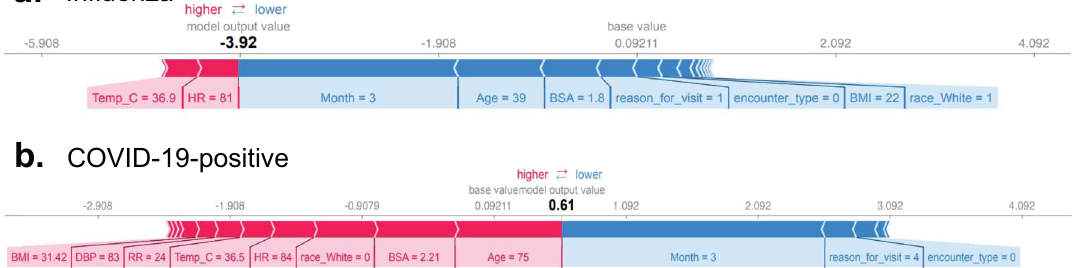
Fig. 4 SHapley Additive exPlanations (SHAP) force plots from an in fl uenza and COVID-19-positive patient. SHAP plots for sample observations from a in fl uenza A/B and b COVID-19-positive predictions. The underlying model is XGBoost. Features that are contributing to a higher and lower SHAP values are shown in red and blue, respectively, along with the size of each feature ’ s contribution to the classi fi cation model ’ s output. The in fl uenza patient in this example shows a log-odds output of − 3.92 in the rating scale, which is equal to a probability of 0.0194. The baseline — the mean of the model output (log-odds) over the training dataset — is 0.092 (translating to a probability of 0.523). The COVID-19-positive patient has a rating score of 0.61 (probability = 0.6479); Age of 75, HR of 84, BSA of 2.21, respiratory rate of 24, and a Temp of 36.5 °C increases the prediction risk, while month of march decreases the predicted risk of being COVID-19 positive.